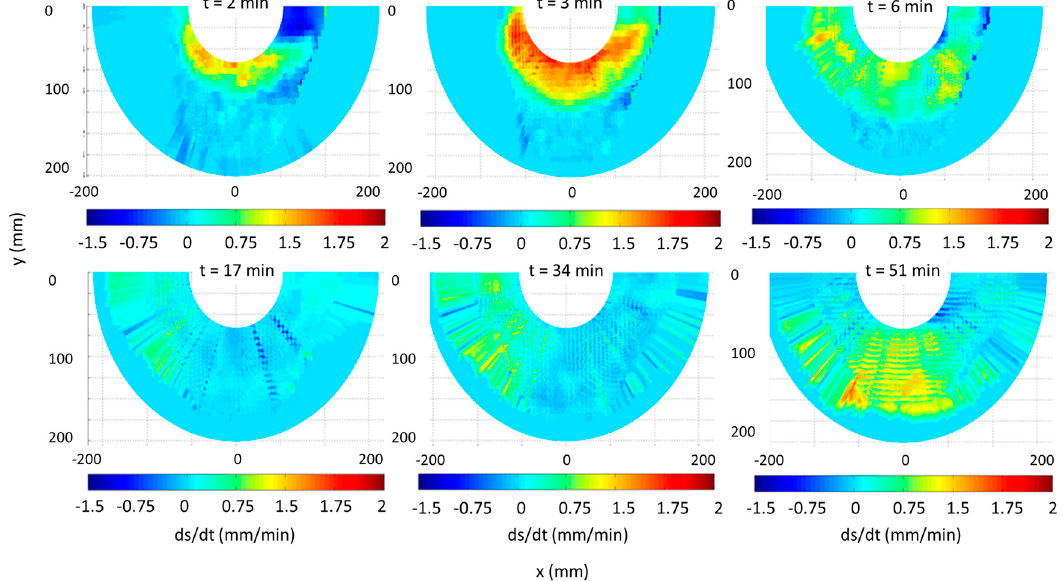
Figure 4. Instantaneous scour rate distributions.